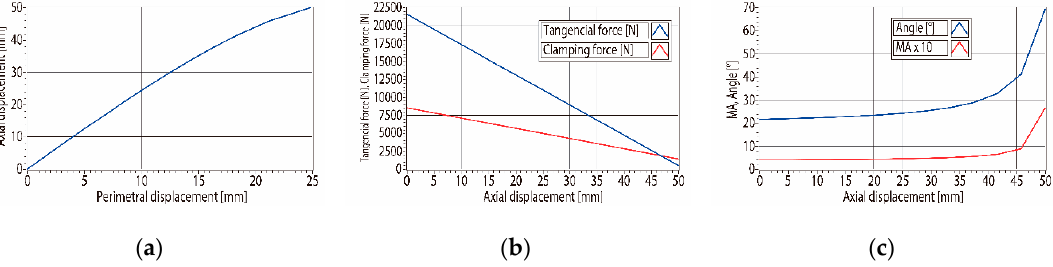
Figure 20. ( a ) Cylindrical cam profile, ( b ) tangential and axial force as a function of axial displacement, ( c ) relationship between forces and profile angle as a function of axial displacement.